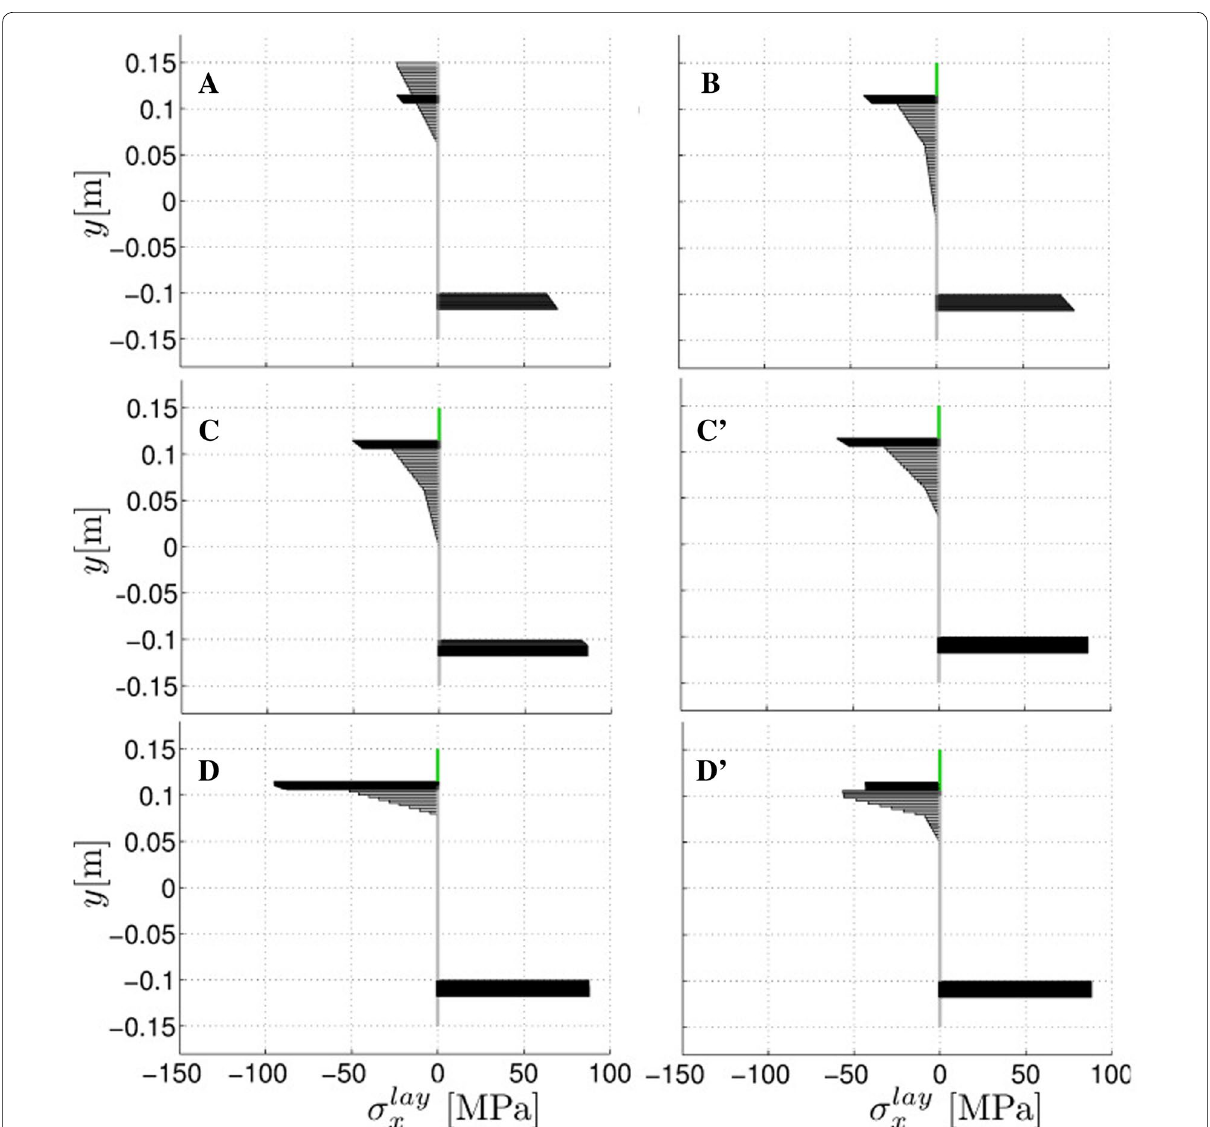
Fig. 11 Composite axial stress distribution close to mid-span at points A to D in Fig. 10 with crushed concrete layers and plastic steel shown in green and black,